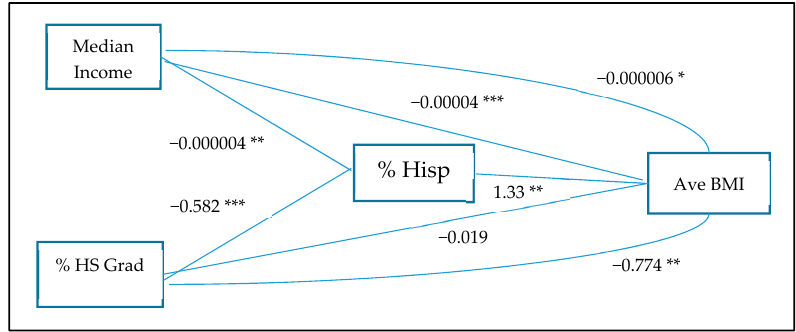
Figure 2. Path analysis for Hispanic ethic concentration on average BMI; * = 0.05; ** = 0.01; *** = 0.001.